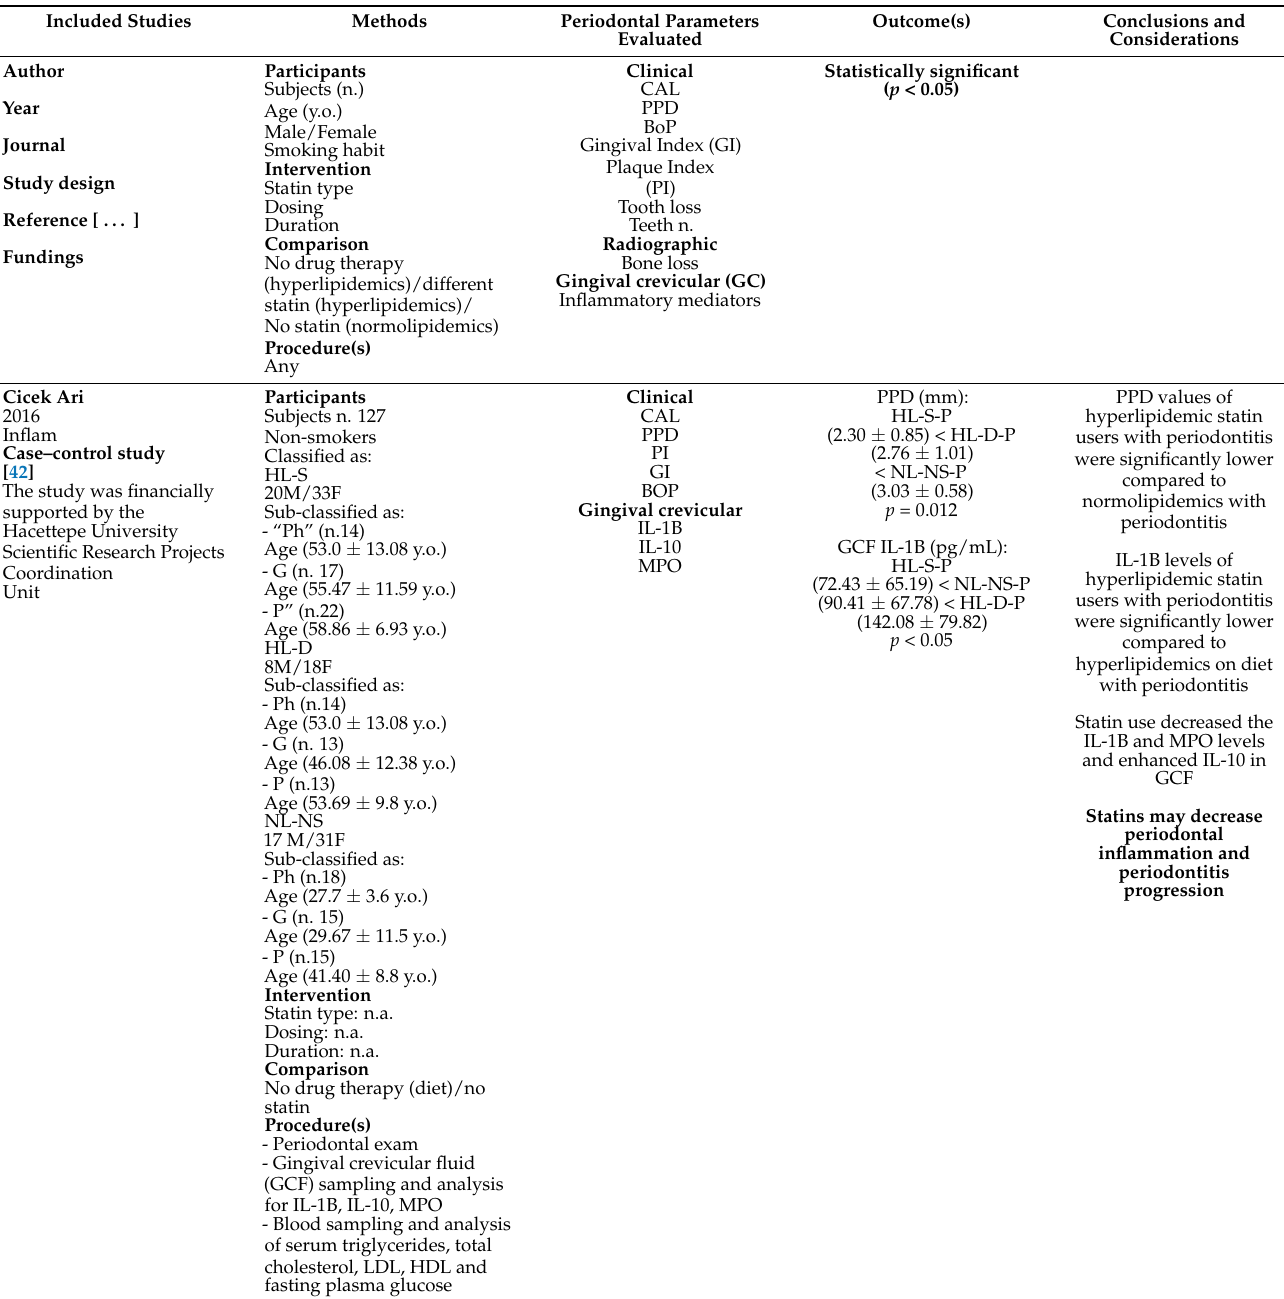
Table 2. Data extracted and collected from the studies included in the present systematic review. General information: first author, year and journal of publication; reference number; fundings. Characteristics of the study: design; participants (sample size, age and gender, smoking habit, comorbidities, treatments and procedures); intervention (statin type, dosing, duration and indication); comparison (no statine use, placebo); outcomes (clinical and radiographic periodontal parameters and Gingival crevicular Inflammatory mediators, assessment timepoints); consideration(s) and conclusion(s). Abbreviations: hyperlipidemics, “HL”; normolipidemics, “NL”; statin users, “S”; non-statin users, “NS”; diet, “D”; exercise, “E”; periodon- tally healthy, “Ph”; with gingivitis, “G”; with periodontitis, “P”; gingival crevicular, “GC”; relative risk, “RR”; p -value, “ p ”. Only statistically significant data concerning the outcomes and focusing on the PICO question have been